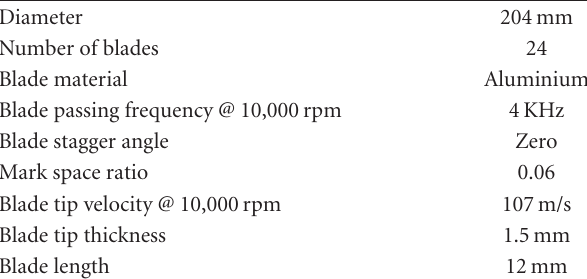
Figure 4: Layout diagram of the complete FM capacitance clearance measurement system used to measure clearance over every blade. Table 1: Spinning rig wheel